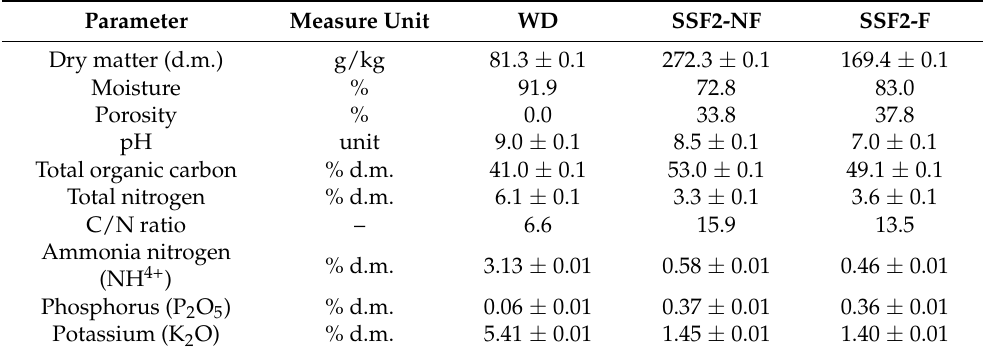
Table 3. Physico-chemical characterization of whole digestate (WD) and solid-state fermentation substrate not fermented (SSF2-NF) and fermented for 6 days (SSF2-F).